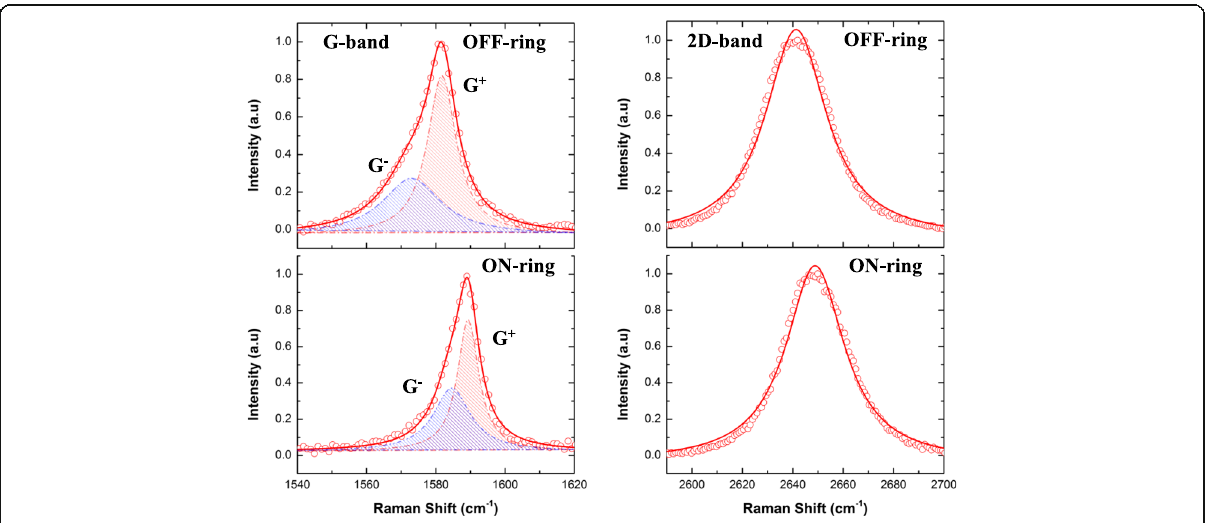
Fig. 3 Representative graphene G (left) and 2D (right) averaged ( n = 3) Raman scattering peaks (633-nm excitation) OFF (top) and ON (bottom) the underlying silicon MRR waveguide structure. Lines represent either double (G peak) or single (2D peak) Lorentzian fits to the data. The asymmetry in the G peak as a result of the lowering of the degeneracy of the in-plane E 2g optical phonon leads to distinct scattering modes, la- belled G + and G − (in keeping with the convention used for carbon